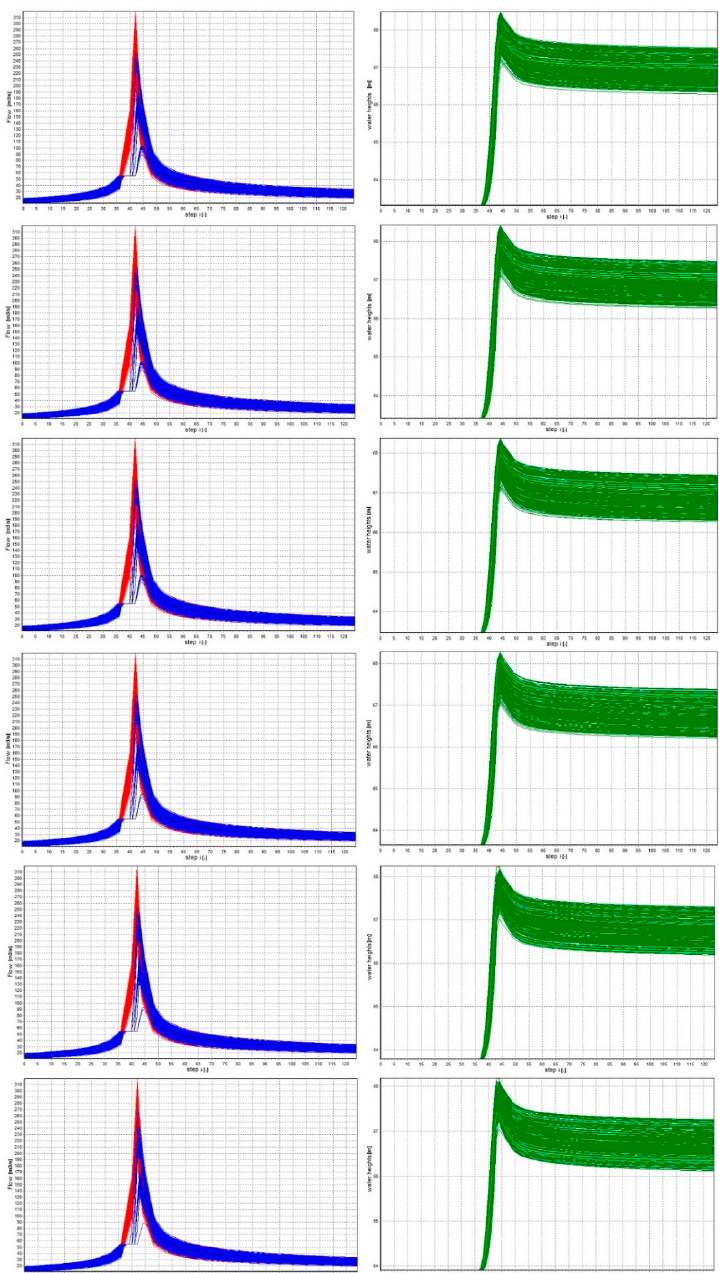
Figure 9. Results of the transformation of generated Q 1000 waves and water heights in the reservoir for the input u B = ±10% for the 75, 80, 85, 90, 95% quantiles and for the upper limit +2 σ of the optimal V Z .